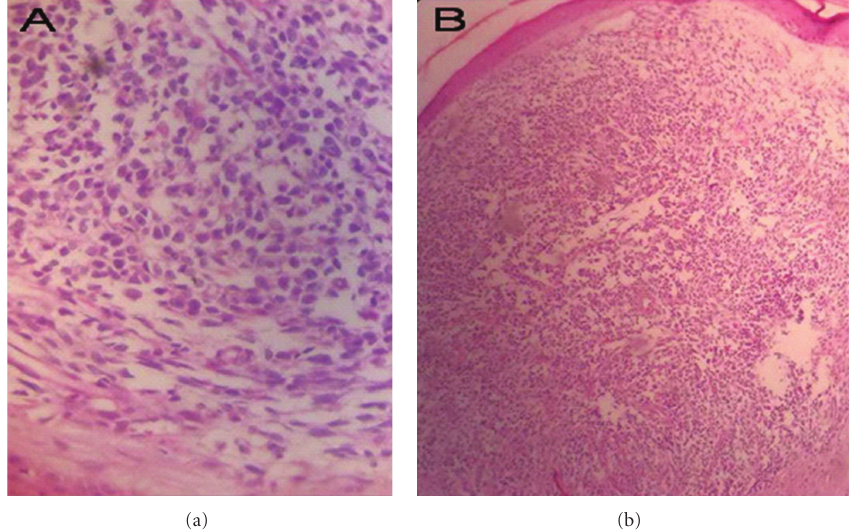
Figure 2: The cells show a combination of shapes but a spindle or elongated morphology is evident overall. Strap cells that look like primitive muscle cells that classically describe in rhabdomyosarcoma are seen in this